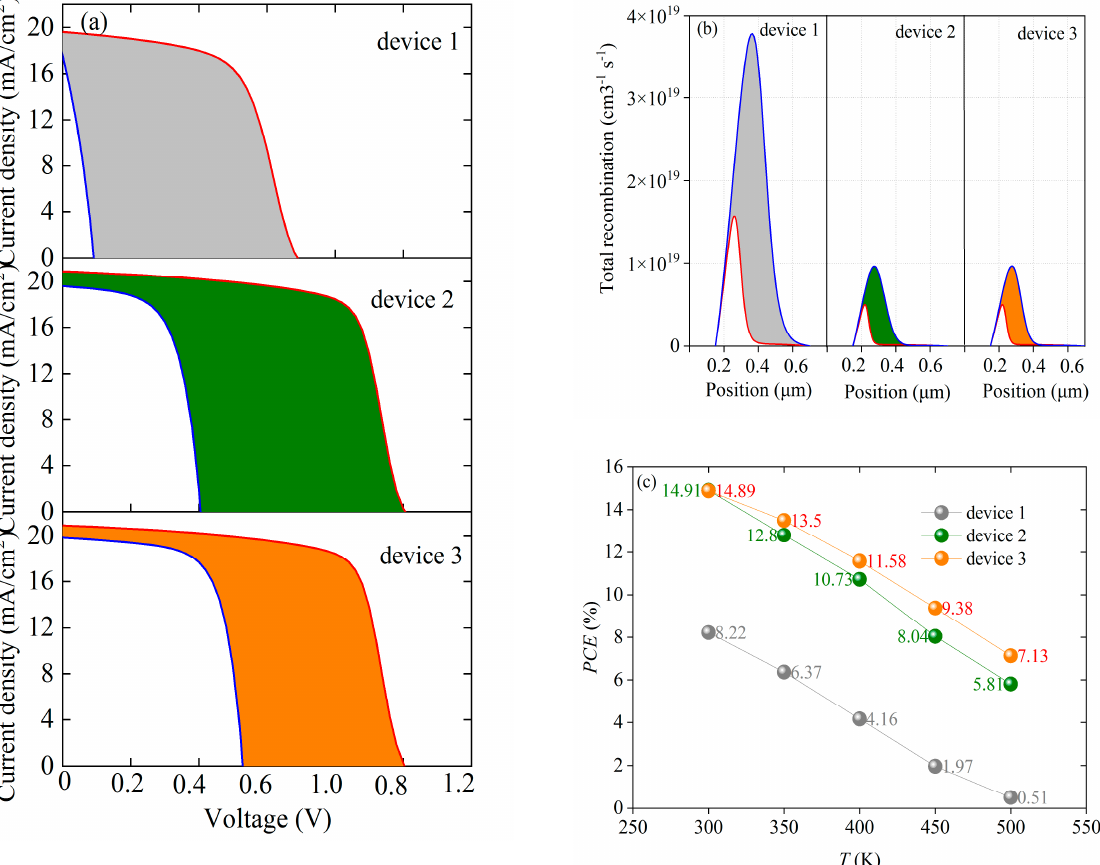
Figure 23. Performance fluctuations of three devices: ( a ) changes in J-V characteristic curves, ( b ) changes in total recombination, ( c ) trends of PCE values with temperature.